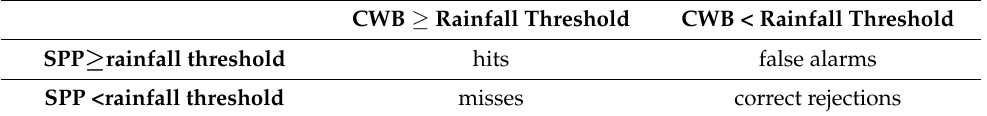
Table 2. Contingency table used for the comparison between rain-gauge observations provided by Taiwan Central Weather Bureau (CWB) and satellite precipitation products